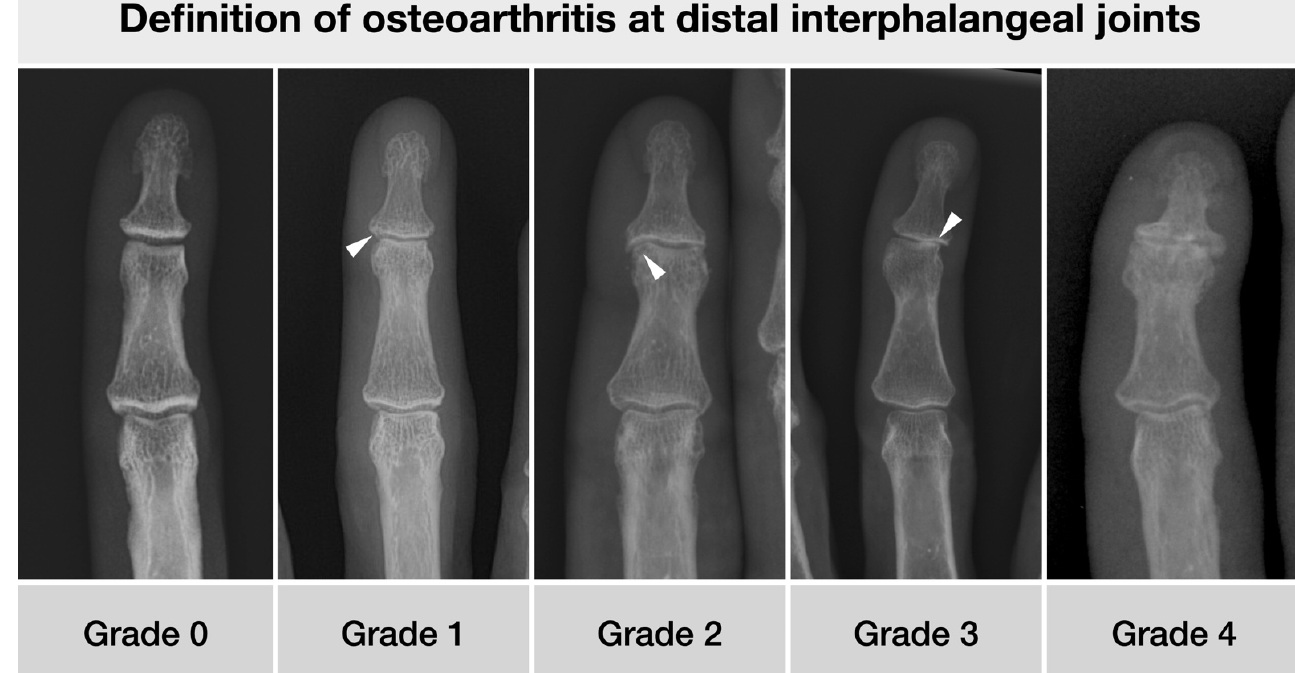
Figure 3. The different degrees of osteoarthritis formation at the distal interphalangeal joints. 0— normal shape; 1—minimal de-rounding (arrowhead) and minute cystic changes; 2—gross osteophytes and cyst formation (arrowhead), joint space yet well preserved; 3—marked asymmetric joint space narrowing (arrowhead); 4—complete joint space narrowing and marked osteophyte formation. Patients’ characteristics from left to right: 46 y/o male, 59 y/o female, 62 y/o male, 63 y/o female, 69 y/o female.